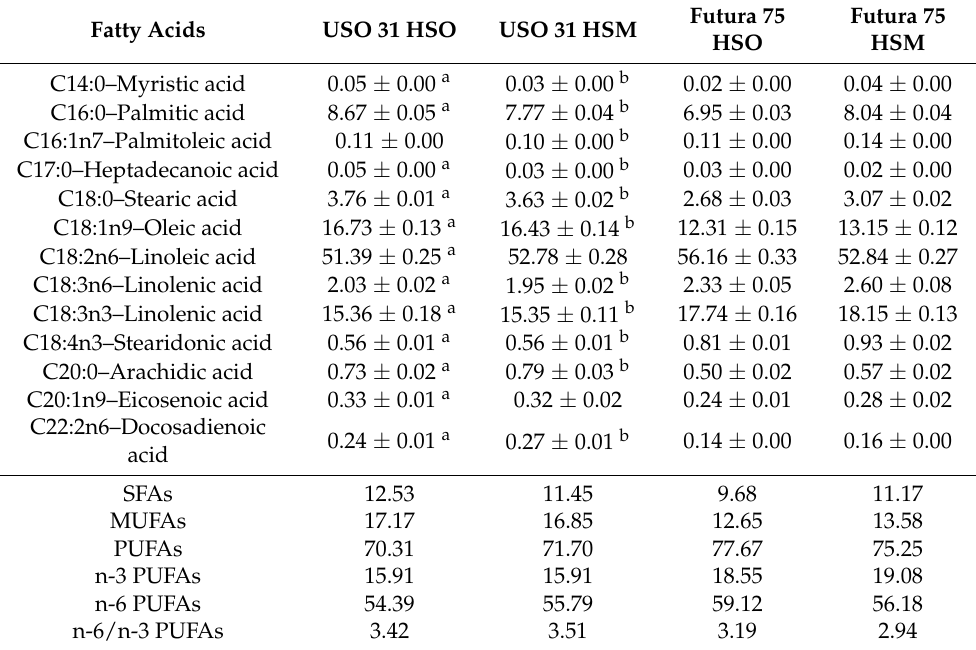
Table 5. Determination of fatty acids profile in USO 31 and Futura 75 hempseeds oil (HSO) and their processing byproducts (hempseed meal, HSM) by GC-FID and GC–MS analysis. Data, which repre- sent the mean ± standard deviations (SD) of three independent experiments ( n = 3), are expressed as percentages (%) of total fatty acid methyl esters (FAMEs). Fatty Acids USO 31 HSO USO 31 HSM